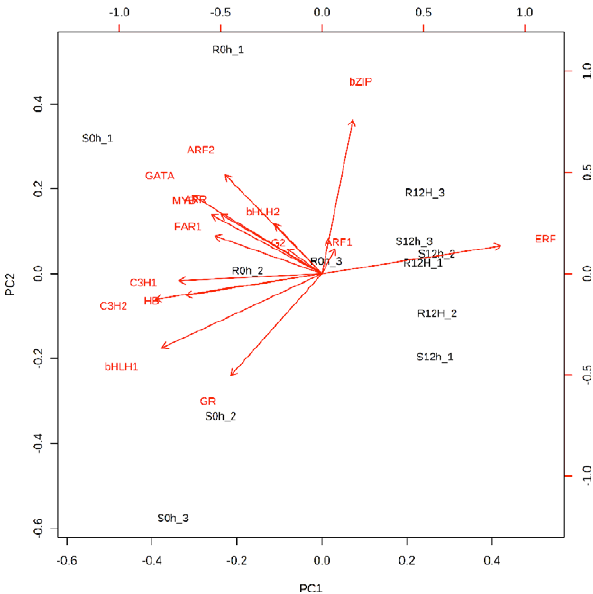
Figure 5. Bi-plot derived from PCA analysis based on the top 15